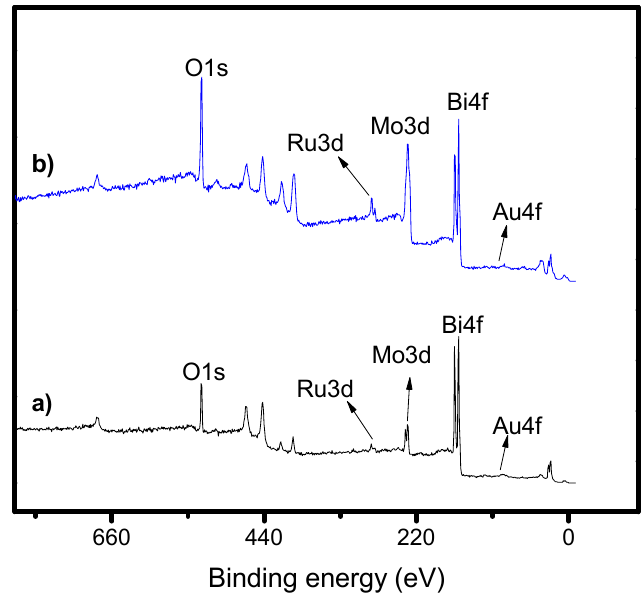
Figure 6. General XPS scans of ( a ) AuMBR1 and ( b ) AuMBR2 catalysts.